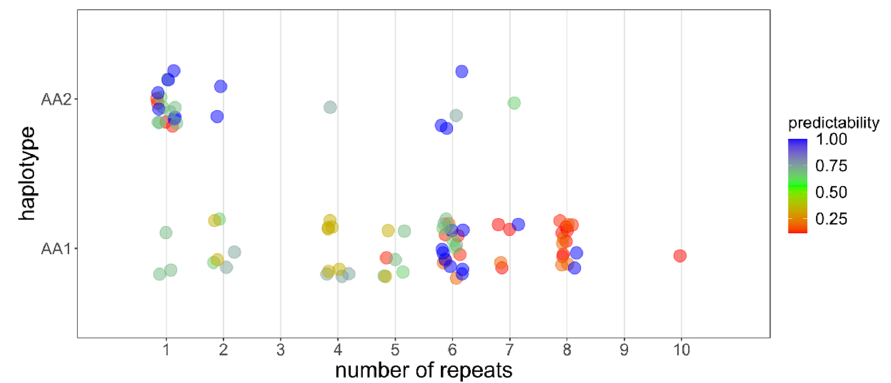
Figure 5. Relationship between the number of repeats in each sequenced allele (full and terminal together), amino acid haplotypes (AA1, AA2) and environmental predictability of the corresponding